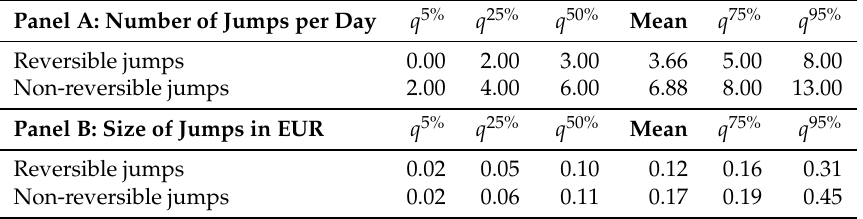
Table 4. Summary statistics for reversible and non-reversible jumps detected in the 41,069 sets of cointegration residuals between the DAX 30 constituents identified on 249 trading days in